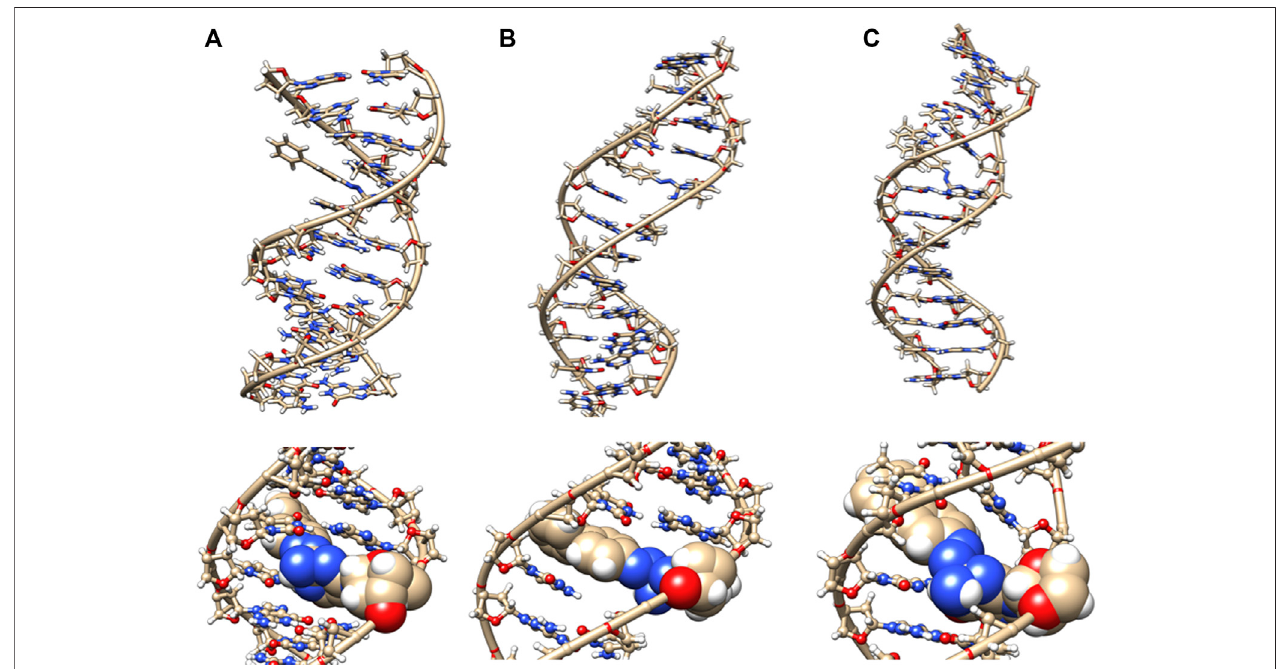
FIGURE 10 | DNA dodecamer with azobiphenyl dye adduct. (A) Initial minimized structure, (B) at 100 ns of MD simulation, and (C) at 1 µs. The bottom row is a zoomed-in version of the adduct region.